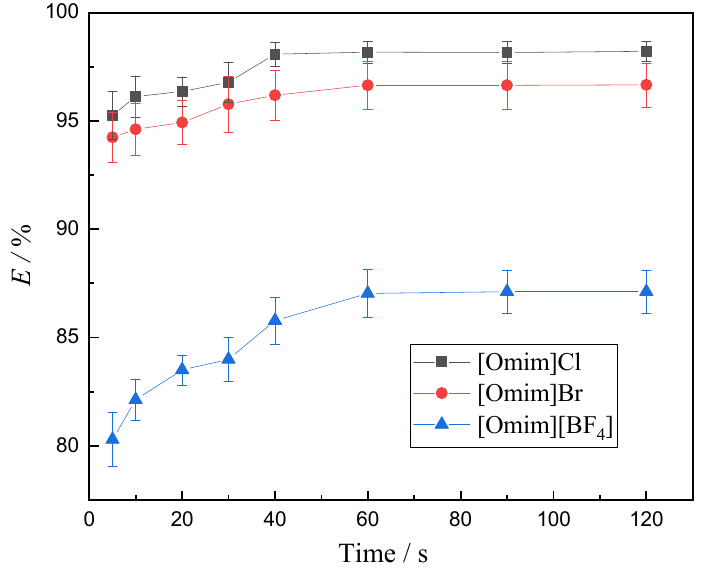
Figure 2. Effect of equilibrium time on the extraction of V (V) (experimental conditions: concentra- tion of V (V) in the aqueous phase 1.75 g · L − 1 , concentration of extractant 0.2 mol · L − 1 , aqueous phase pH 8.051, and extraction temperature 25 °C; relative standard uncertainty: confidence probability p = 95%, u rA =0.72%, u rB =0.35%, u r =0.8%). pH 8.051, and extraction temperature 25 ◦ C; relative standard uncertainty: confidence probability p = 95%, u rA = 0.72%, u rB = 0.35%, u r = 0.8%).